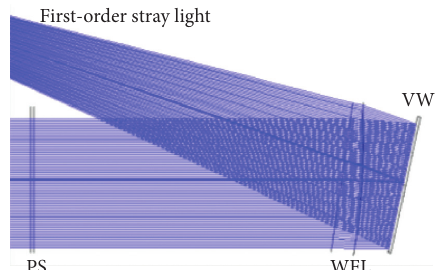
Figure 8: The first-order stray light reflected by